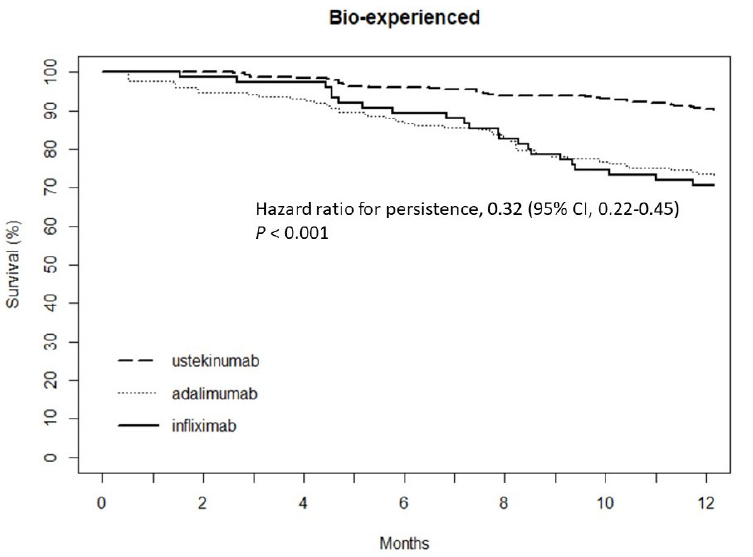
Figure 2. Comparison of persistence between anti-TNF inhibitors and ustekinumab in bio-experienced CD patients.